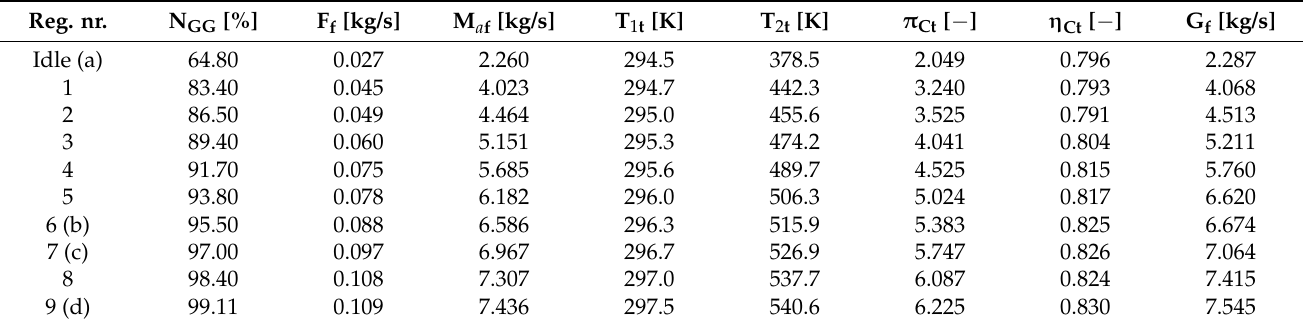
Table 4. Calculated data at each engine working regime, part one.